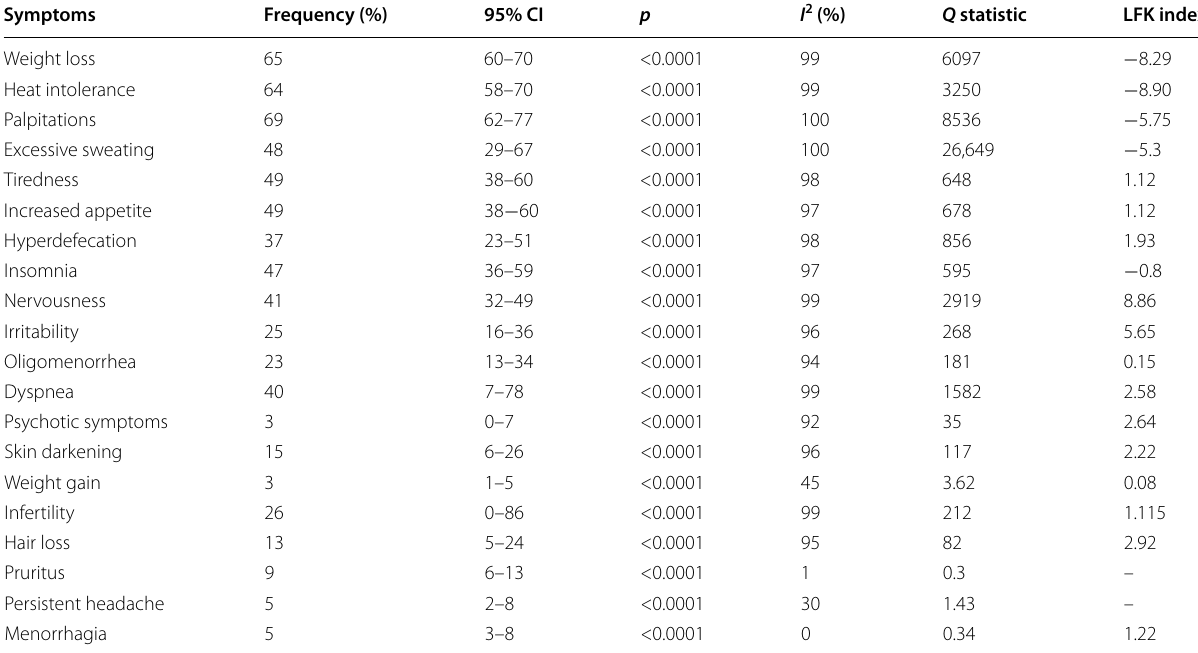
Table 6 Pooled frequency of the